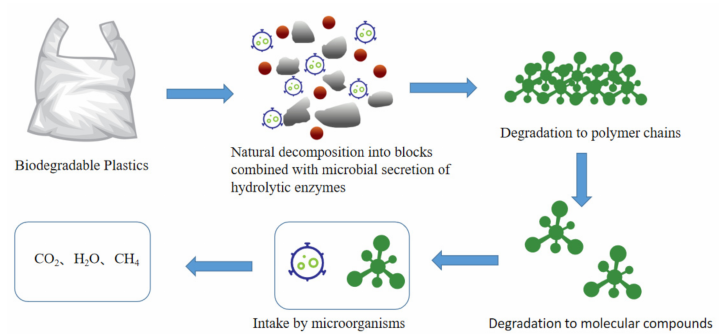
Figure 3. The mechanism of